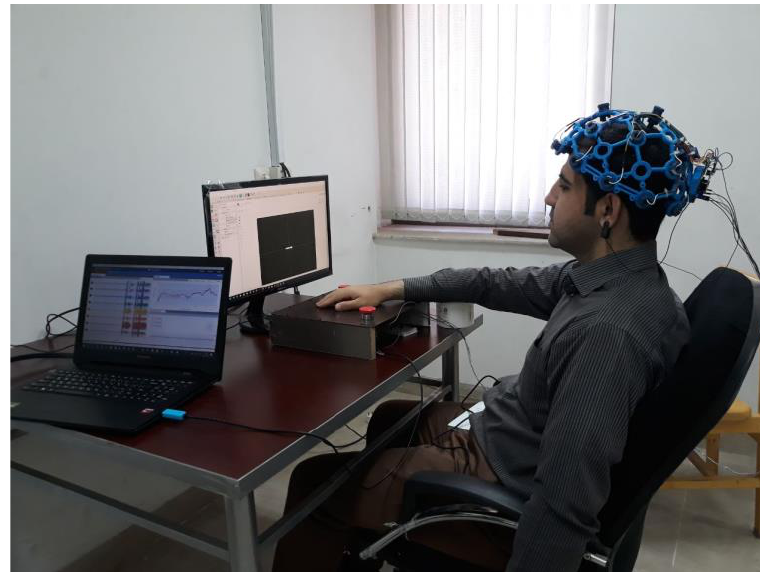
Figure 2. Recording of the EEG signal while tapping for subject 1.